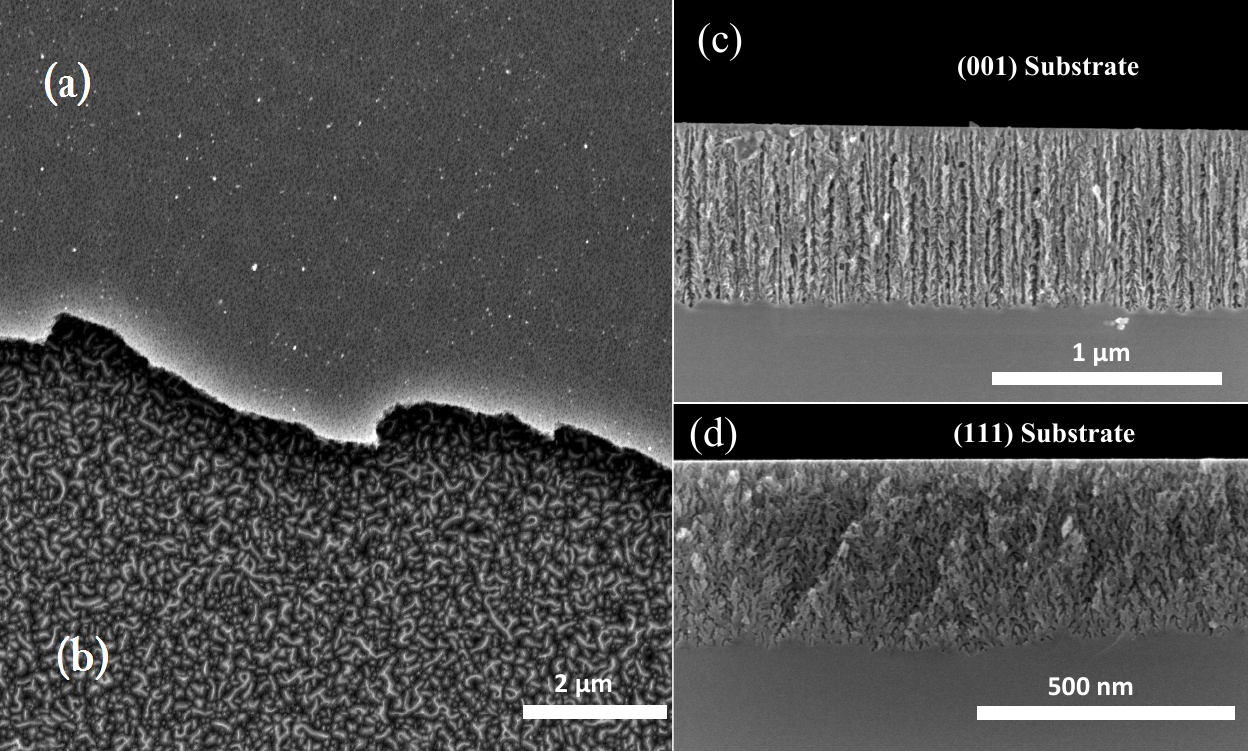
Figure 1. SEM images of the top view of the PSi double layer where ( a ) the first layer was anodized at 5 mA/cm 2 and ( b ) the second one was anodized at 60 mA/cm 2 . Cross-section of single PSi films fabricated at 5 mA/cm 2 using ( c ) (001) and ( d ) (111) substrate. The most critical features of PSi formation are its dependence on pore nucleation and growth of the substrate direction and the self-limited electrochemical reaction. That behavior allows to tune the refractive index of porous silicon and to fabricate multilayered